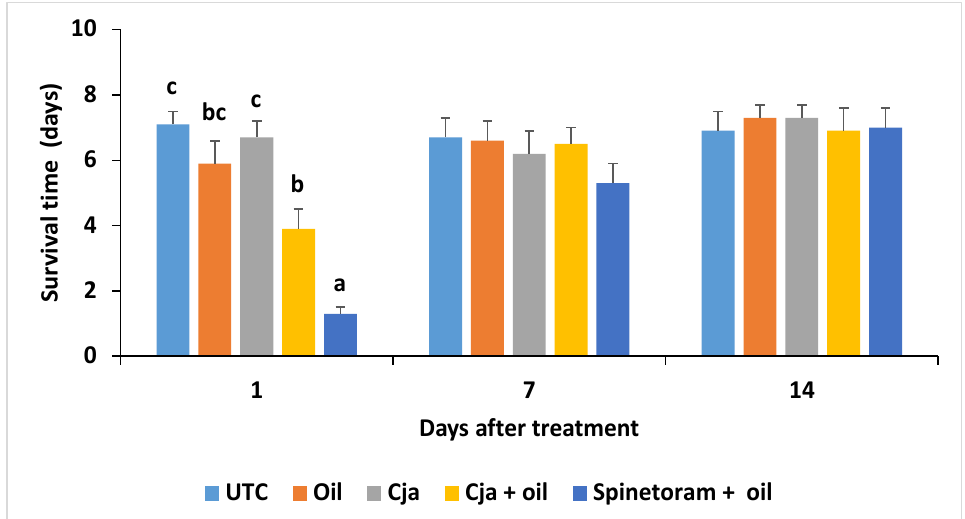
Figure 6. Mean survival time ± SE of AsCP adults on disks from leaves collected at 1, 7 and 14 days after treatment for Trial 2. The mean values with a different letter above the ±SEM bar are significantly different at 1 day after treatment (Tukey’s test; p < 0.05). The mean survival times were not significantly different ( p > 0.05) among the treatments at 7 and 14 days after treatment. The untransformed data are presented. UTC = untreated control; Cja = Cordyceps javanica .